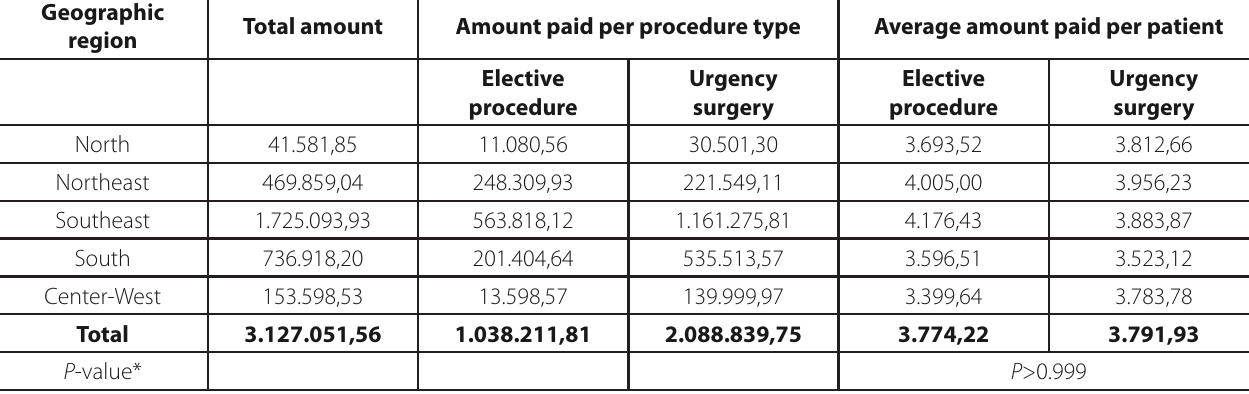
Table 3. Values reported by the Sistema Único de Saúde in US dollars per geographic region by procedure type. Geographic Total amount Amount paid per procedure type Average amount paid per patient region Elective Urgency Elective Urgency procedure surgery procedure